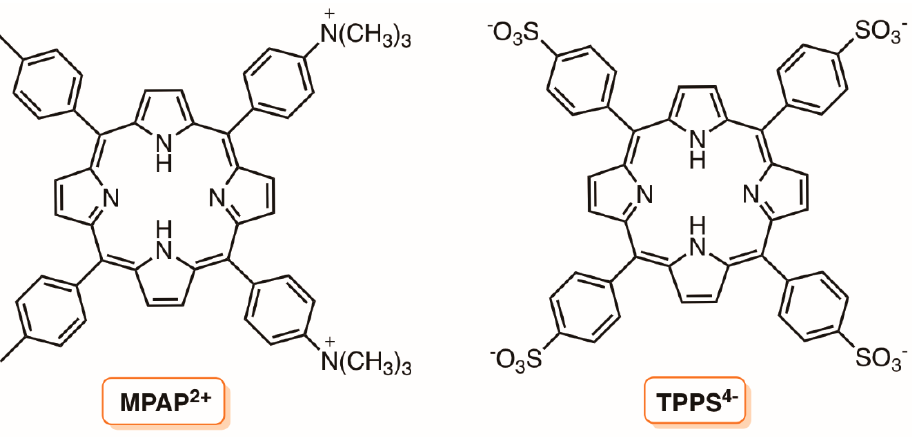
Figure 21. Structures of 5,10-di(4-methylphenyl)-15,20-di(4- N,N,N -tri-methylammoniumphenyl)porphyrin (MPAP 2+ ) and 5,10,15,20-tetrakis(4-sulphonatophenyl)porphyrin (TPPS 4 − ) (adapted from Reference [123]).